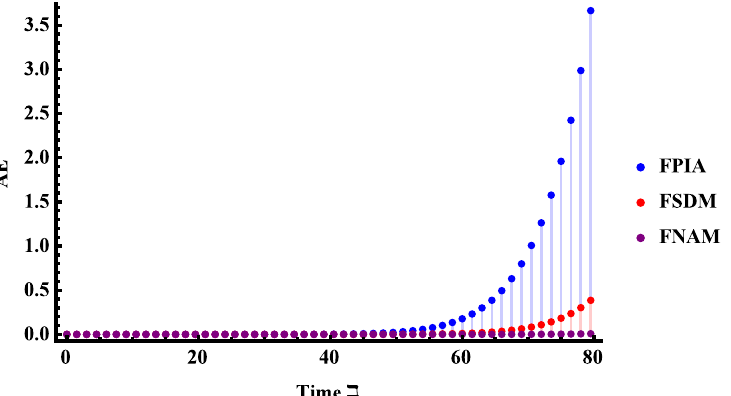
Figure 5. Graphical comparisons of Absolute Errors (AE) of obtained solutions by FPIA, FSDM, and FNAM.